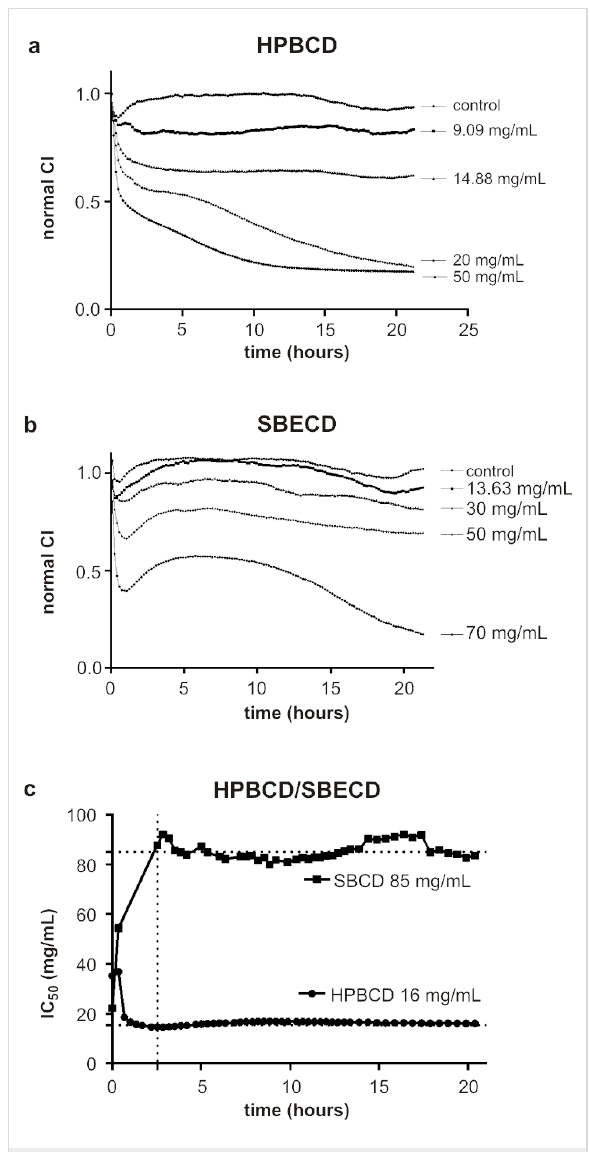
Figure 3: Ocular cytotoxicity studies of HPBCD and SBECD in prima- ry corneal human keratocytes, using real-time xCELLigence imped- ance analysis. (a) Kinetic curve survival rates for HPBCD; (b) Kinetic curve survival rates for SBECD; (c) Evolution of IC 50 vs time for HPBCD and SBECD. IC 50 values at each time were calculated using (a) and (b); IC 50 represents the concentration that causes a reduction in the survival of 50% of the